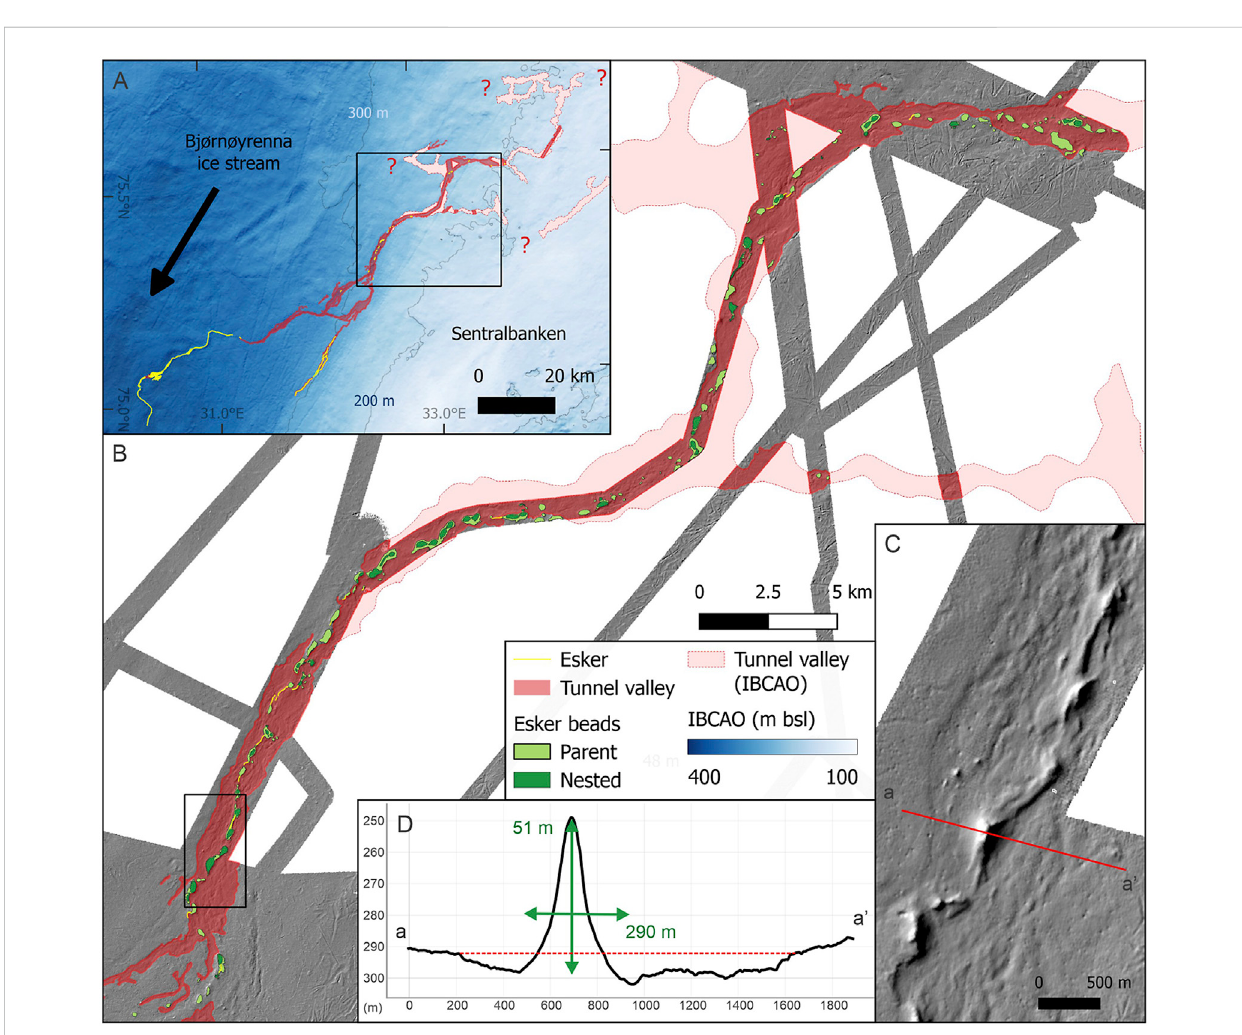
FIGURE 7 (A-B) The Hopendjupet tunnel valley and beaded-esker system, extending upstream onto Sentralbanken. (C) A closer view of beads towards the southern end of the esker chain. (D) Dimensions of individual beads reach up to ~50 m in height, and ~300 m in width. Dimensions of the tunnel valley (red dashed line) vary from 8 to 12 m deep and 300 – 1500 m